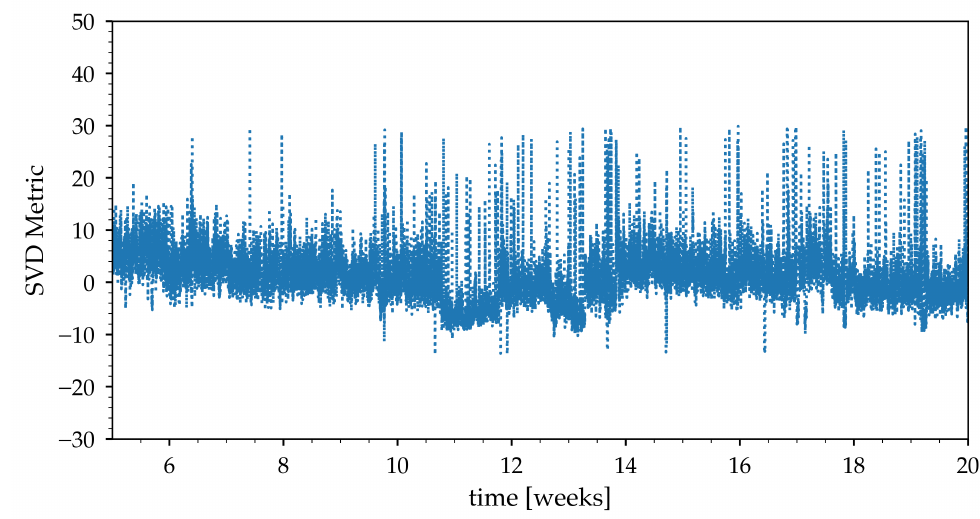
Figure 9. Aggregate singular value decomposition of the amplitude and phase measurements plotted as a function of time during the period of interest.